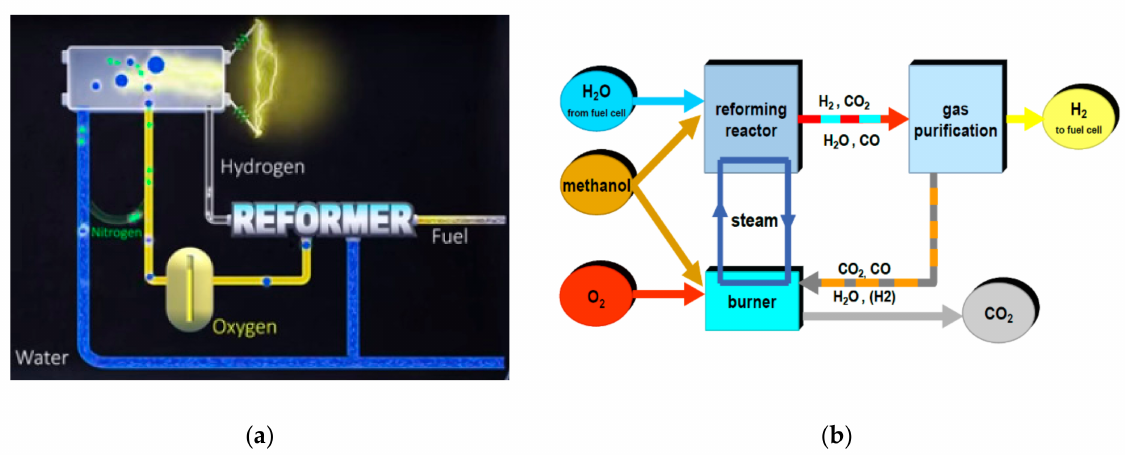
Figure 9. Schematic of Reformer Configuration for Use in a Submarine. ( a ) Hydrogen fuel cell with reformer and feedstock [59], ( b ) Methanol reformer configuration [55].